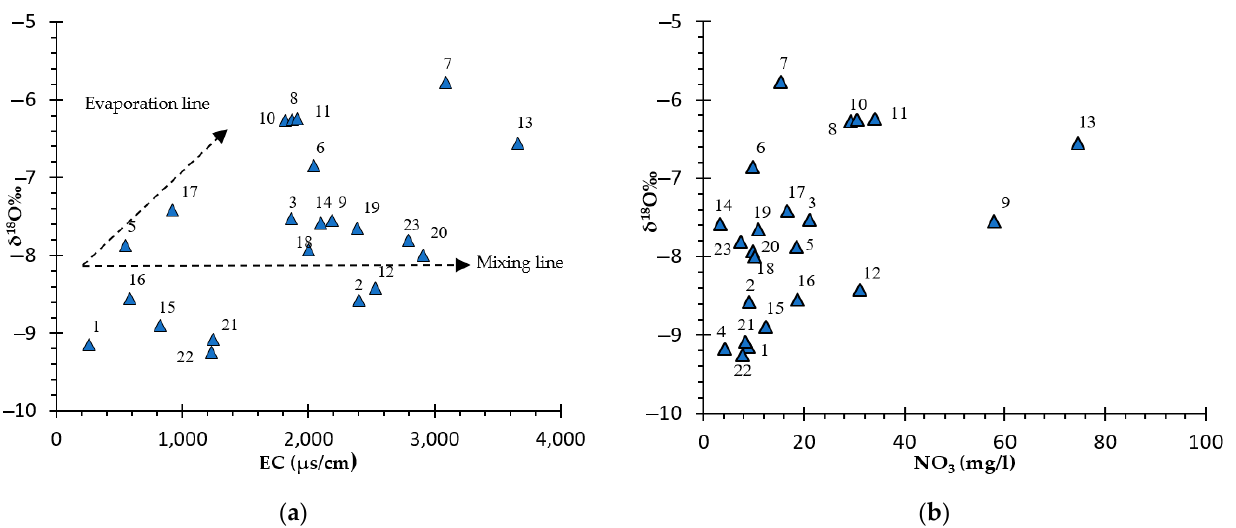
Figure 10. ( a ) Plot of δ 18 O vs. electrical conductivity. ( b ) Plot of δ 18 O vs. nitrate concentration .